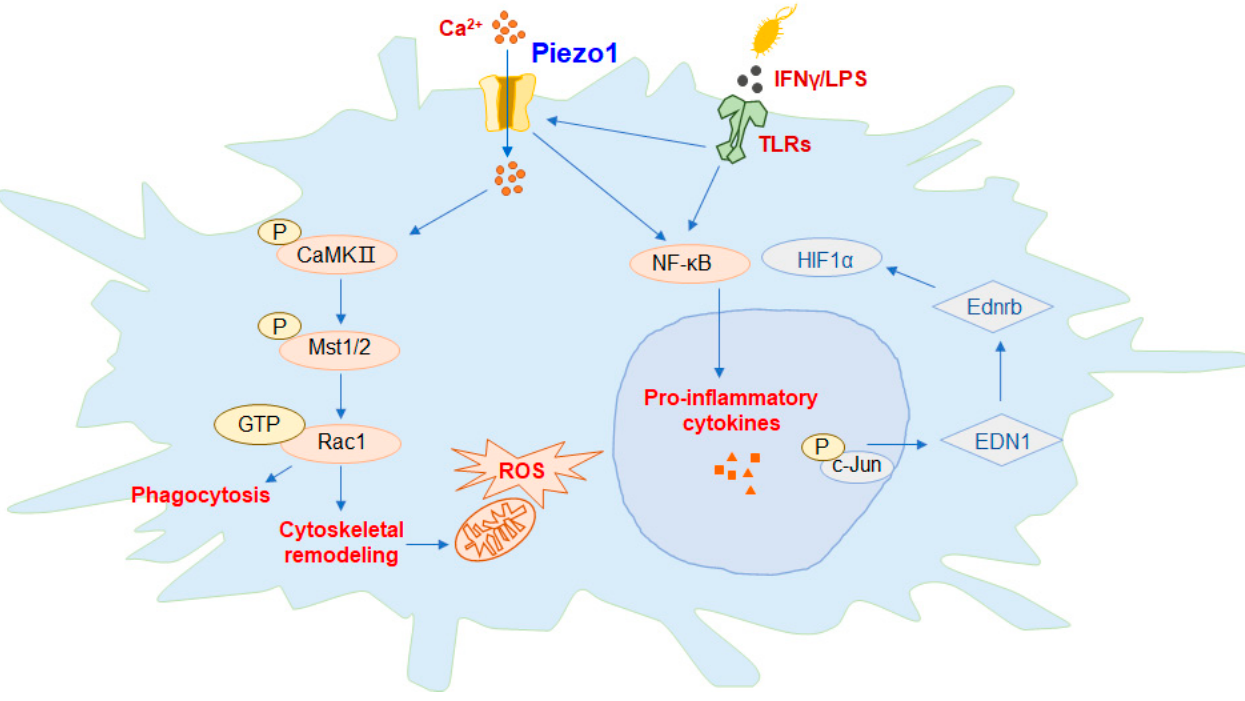
Figure 2. Piezo1 regulates the function of macrophages. In macrophages, activation of Piezo1 channel proteins can promote the expression of downstream proteins and the phagocytic activity of macrophages, polarizing the cells to the M1 phenotype. Figure 2 summarizes the available mechanisms by which Piezo1 activates macrophages, including activation of Piezo1, either directly or through interactions with toll-like receptor (TLR), controls Ca 2+ transport into the cell, promotes endothelin-1 (EDN1) expression, induces nuclear translocation of hypoxia irreducible Factor 1 α (HIF1 α ) and